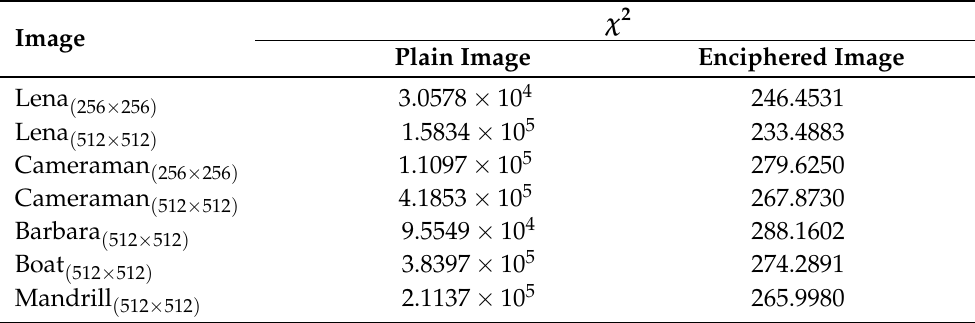
0.29, c 2 = 0.9, x 0 = − −